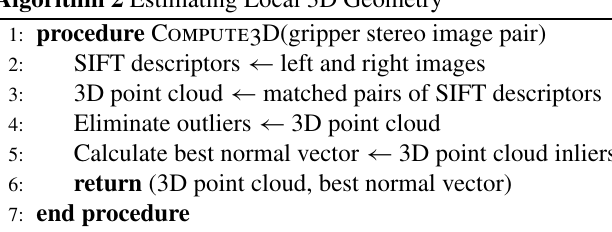
Algorithm 2 details the computation of the local